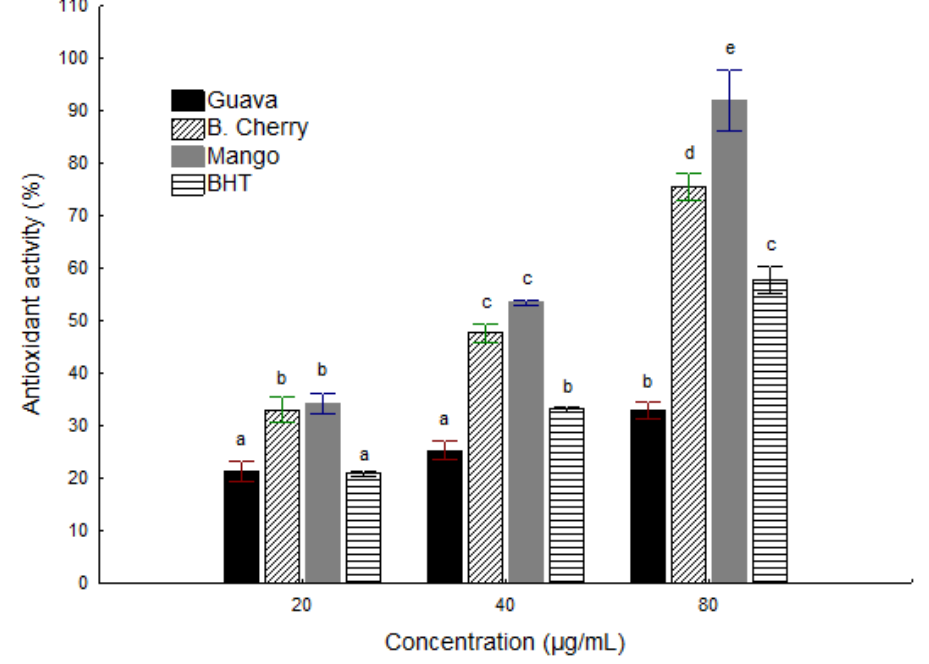
Figure 1. Antioxidant activity of extracts of fruit co-products compared with BHT against the DPPH